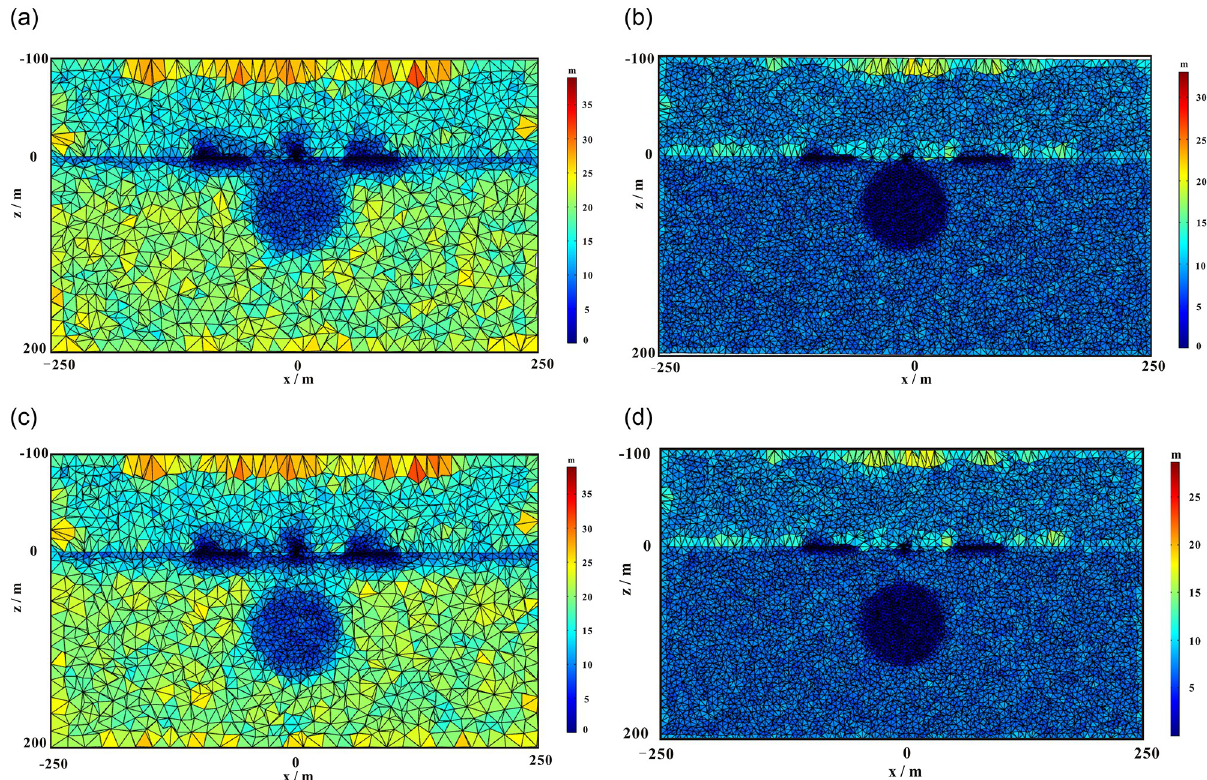
Fig 13. Vertical section at y = 0 of (A) a coarse and (B) a fine tetrahedron mesh for a shallow single water-body geoelectric model. Vertical section at y = 0 of (C) a coarse and (D) a fine tetrahedron mesh for a deep single water-body geoelectric